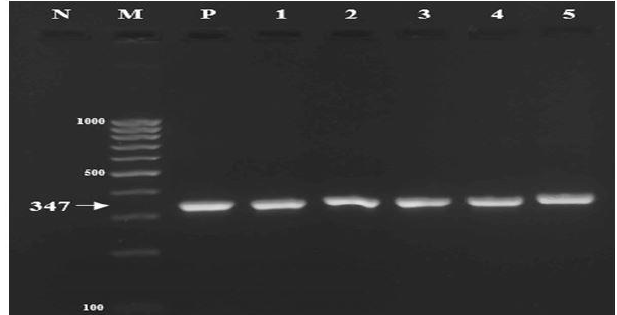
Fig. 2: PCR products of Stx1 gene. Lane M, DNA molecular standard; lane 1-5 positive tested samples giving 347bp product size; lane N, negative control and lane P control positive.